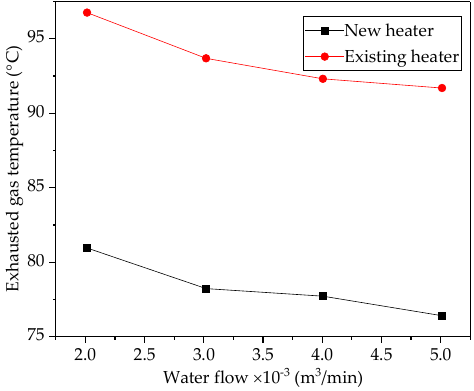
Figure 8. Exhausted flue gas temperature.